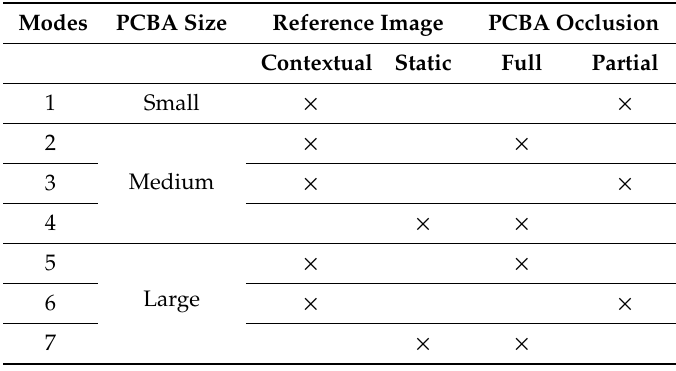
Table 3. Projector-based configuration tests.